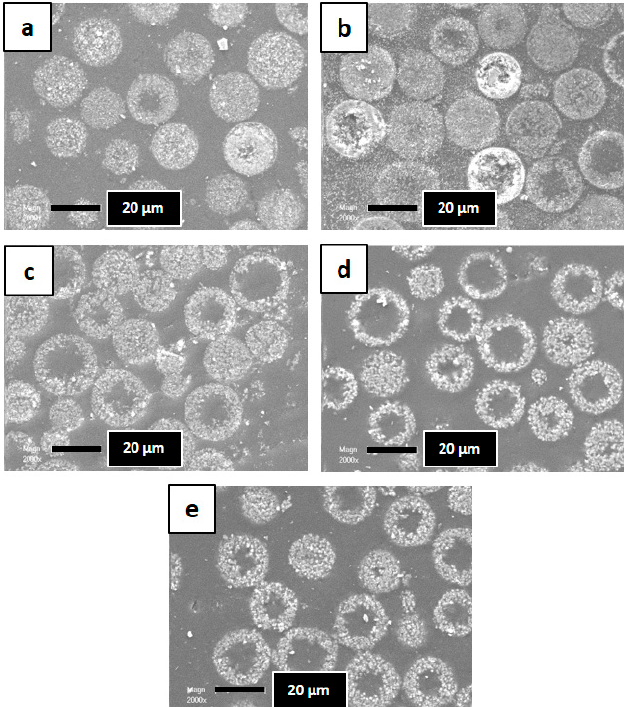
Figure 4. SEM images of the synthesized silicalite ‐ 1 beads embedded in polymer and grinded. Silicalite ‐ 1 beads are presented as a function of their temperature and duration synthesis (B ‐ T(°C) ‐ t(days)): ( a ) B110 ‐ 3, ( b ) B110 ‐ 5, ( c ) B130 ‐ 2, ( d ) B150 ‐ 1, and ( e ) B150 ‐ 5.